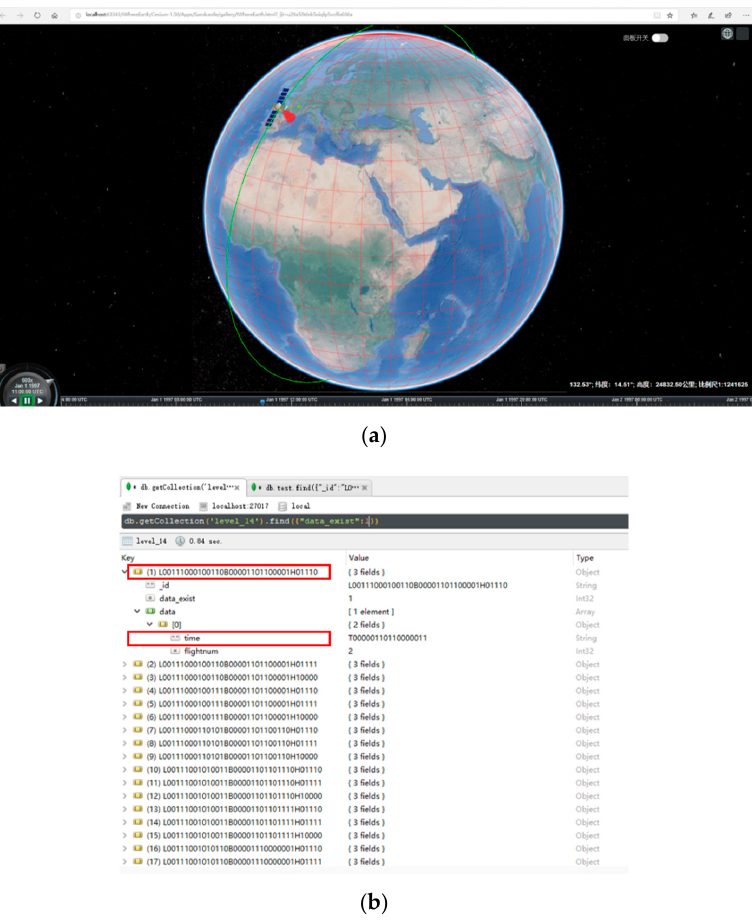
Figure 9. System interfaces: ( a ) satellite with codes in CesiumJS; ( b ) data stored in MongoDB.